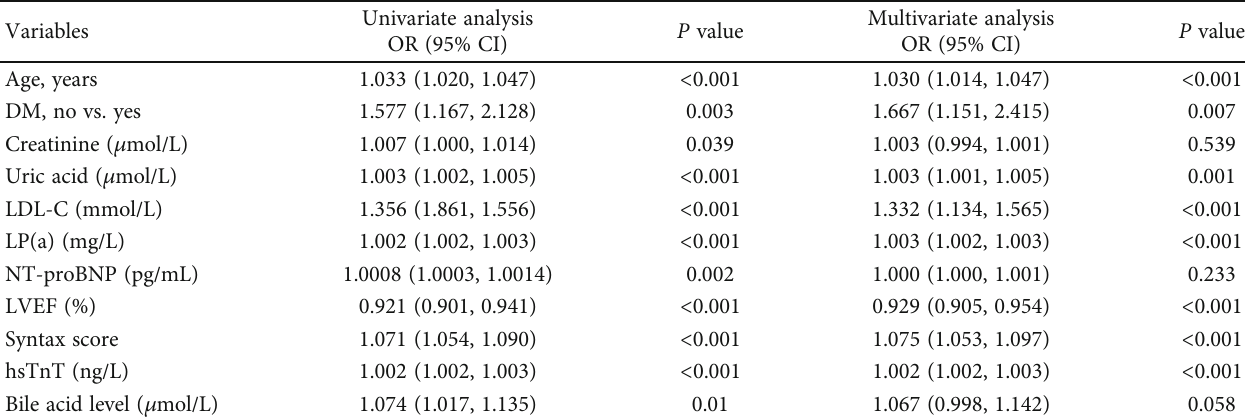
Table 2: Univariate and multivariate logistic regression analyses for 1-year